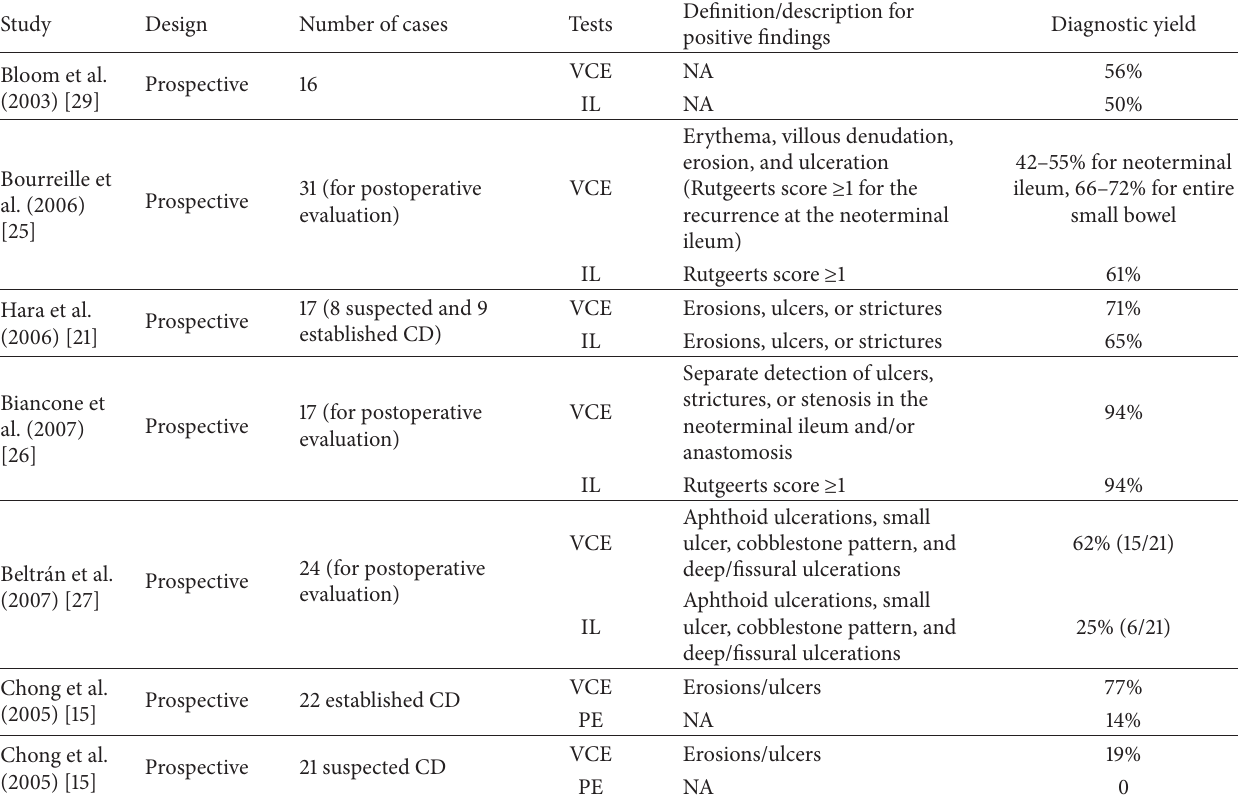
Table 4: Comparison of video capsule endoscopy with ileocolonoscopy or push enteroscopy: diagnostic yield or performance for suspected or established Crohn’s